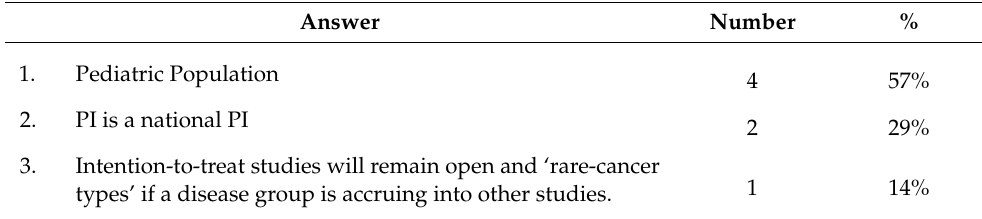
Table 4. Trial types that were exempt from closure.